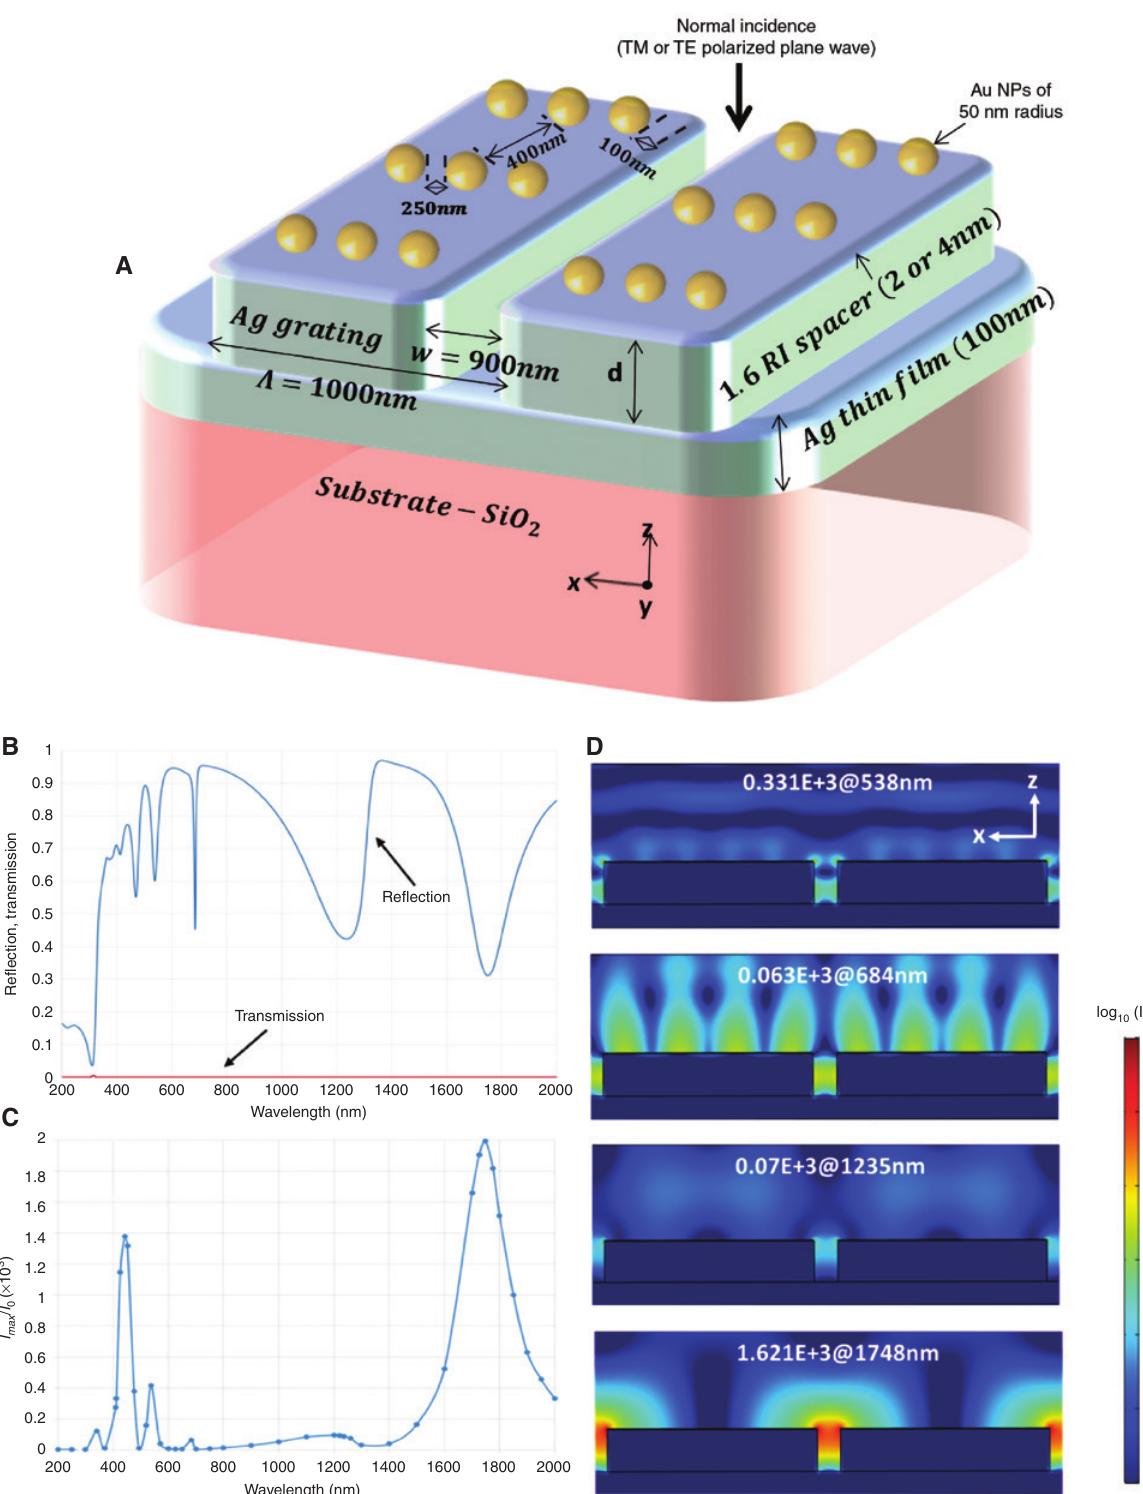
Figure 23: Ultrahigh field enhancement under ESP-LSP and cavity modes-LSP coupling in thick metal grating geometry. (A) Schematic of thick metal grating on thick metal film. (B) Reflection and transmission spectra without the NPs with the grating and the dielectric spacer thicknesses are 180 nm and 4 nm, respectively. The calculations were done under TM polarization. (C) Maximum field intensity enhancement versus wavelength. (D) Intensity distribution at some resonances observed in the reflection spectrum. The legends in the figures in (D) show the maximum intensity enhancement at the specific wavelengths. Reproduced with permission from